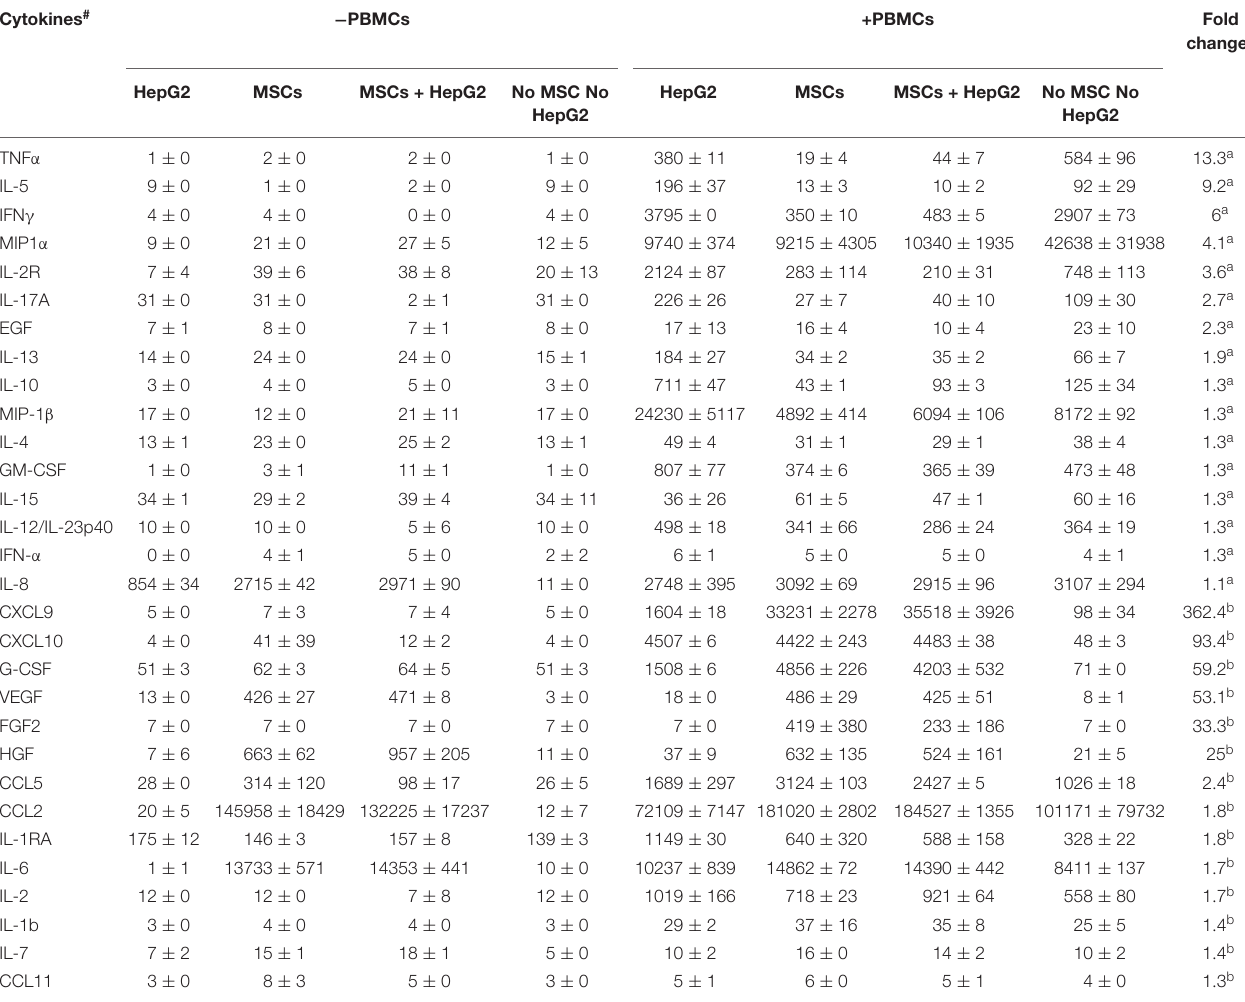
TABLE 1 | Secretome of the tripartite interaction of MSCs, PBMCs, and HepG2 cells. Cytokines # − PBMCs +PBMCs Fold